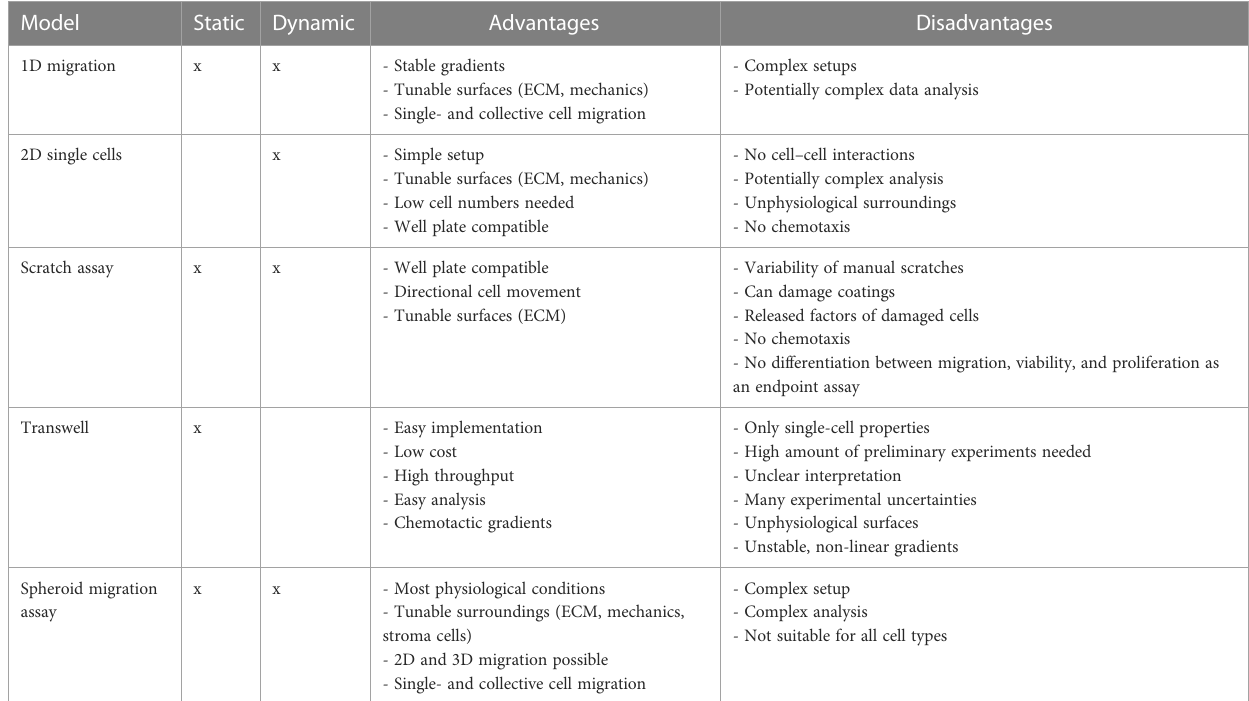
TABLE 1 Summary of the migration